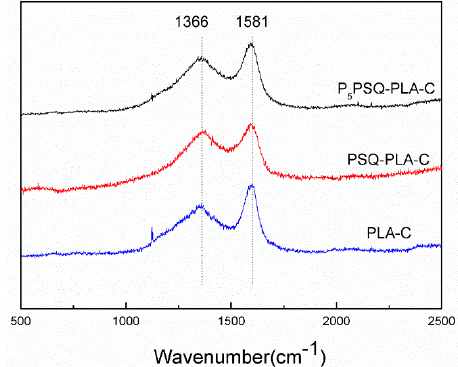
Figure 11. Raman spectra of the char residues of PLA and its flame retardant composites.